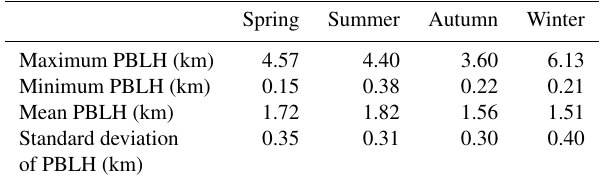
Table 1. Statistics of the CALIOP-derived PBLH in different sea- sons during the period 2011–2014. The mean PBLHs for all the grids are first calculated in China; then the maximum and minimum values of PBLHs are determined by sorting all the mean values. Meanwhile, the mean and standard deviation values of PBLH are determined as the average of mean values at every grid in